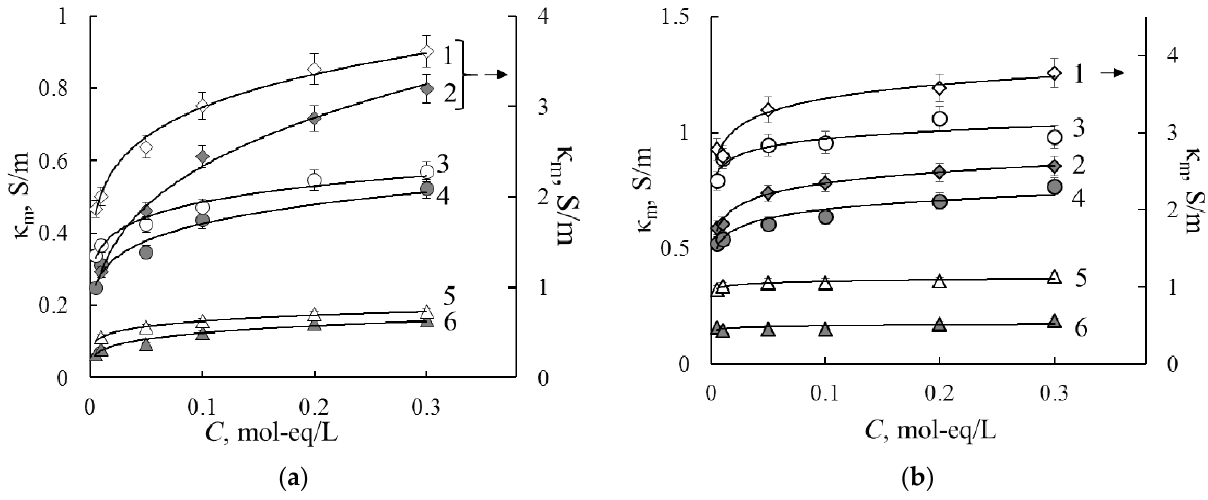
Figure 4. Conductivity concentration dependencies for the MK-40 ( a ), MK-40/PANI ( a ), MF-4SK ( b ) and MF-4SK/PANI ( b ) membranes in HCl (1, 2), NaCl (3, 4) and CaCl 2 (5, 6) solutions.